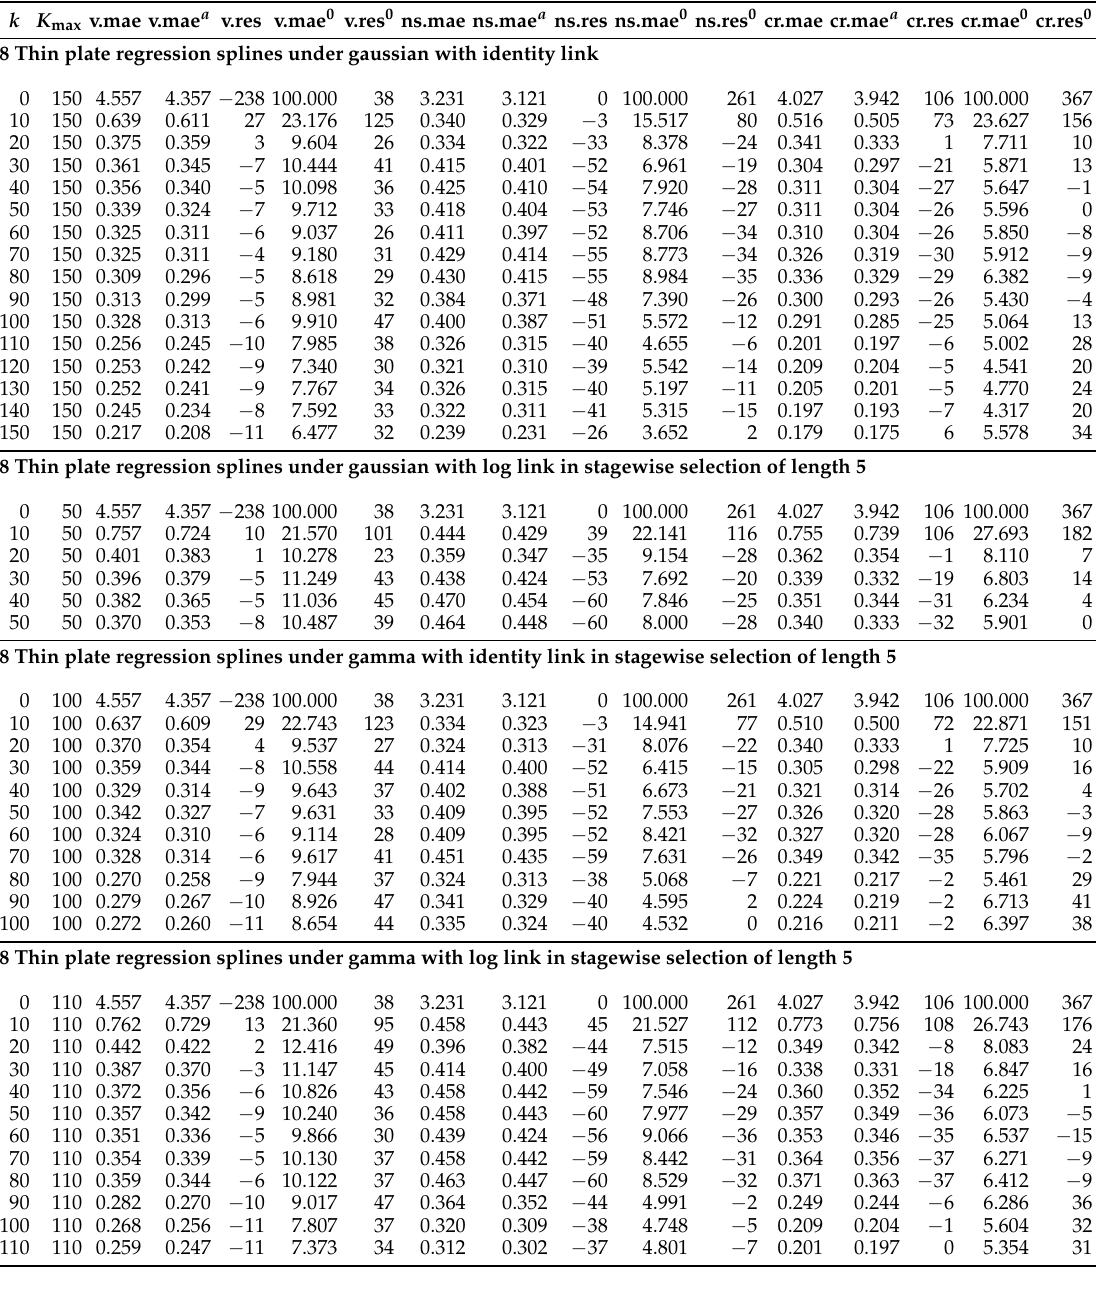
Table A20. Out-of-sample validation figures of selected GAMs of BEL with varying random component link function combination and fixed spline function number of 8 per dimension under between 50–443 and 150–443 after each tenth and the finally selected smooth